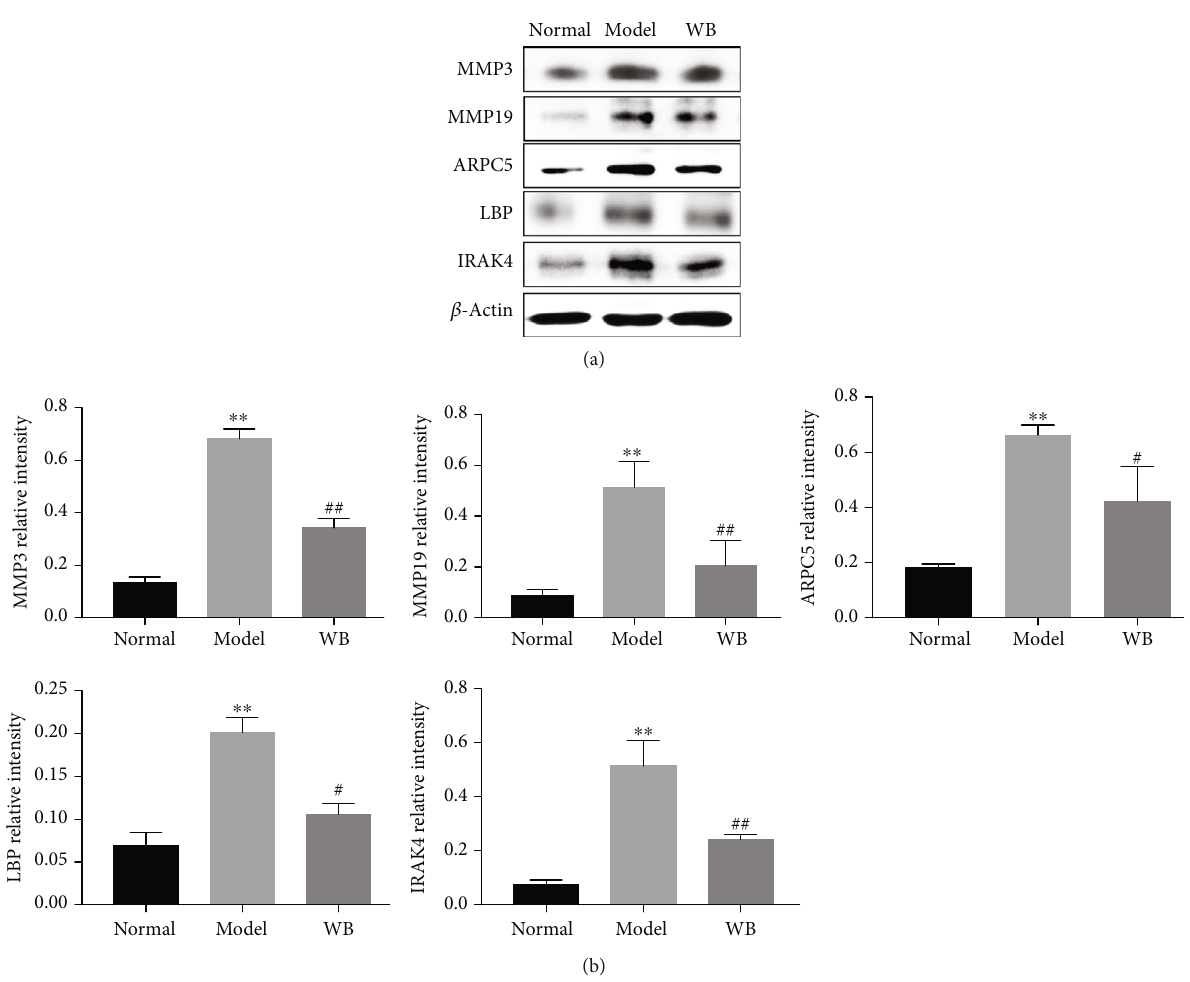
Figure 6: The validation of DEPs. (a) Representative bands of western blot in di ff erent groups. (b) Semiquantitative analysis of western blot in di ff erent groups. Data were mean ± SD , n = 3 . ∗∗ P < 0 : 01 compared with the normal group; ## P < 0 : 01 and # P < 0 : 05 compared with the model